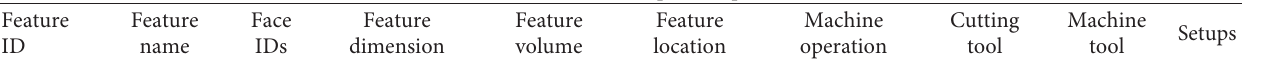
Table 4: Subtractive process plan.